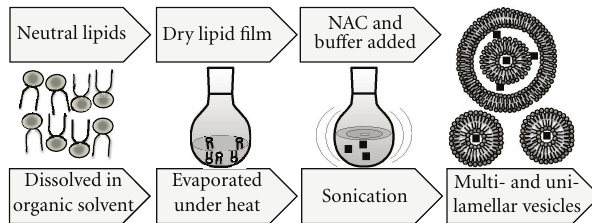
Figure 2: Preparation of liposomal-N-acetylcysteine (L-NAC). L- NAC is prepared from a mixture of DPPC and NAC in a 1:1 molar ratio by a dehydration-rehydration method. The lipids are dissolved in chloroform in a round-bottomed flask and dried at 45 ◦ C with a rotary evaporator. The lipid film is dried with nitrogen to eliminate traces of chloroform and hydrated with a solution of NAC and subsequently sonicated. Sonication is a simple method for reducing the size of liposomes. Upon rehydration, free NAC is separated by high-speed centrifugation (24400g at 4 ◦ C, for 30 min), a step performed twice. At the end of this procedure, the liposomal vesicle size is usually below 200 nm mean diameter with an encapsulation e ffi ciency of 35%